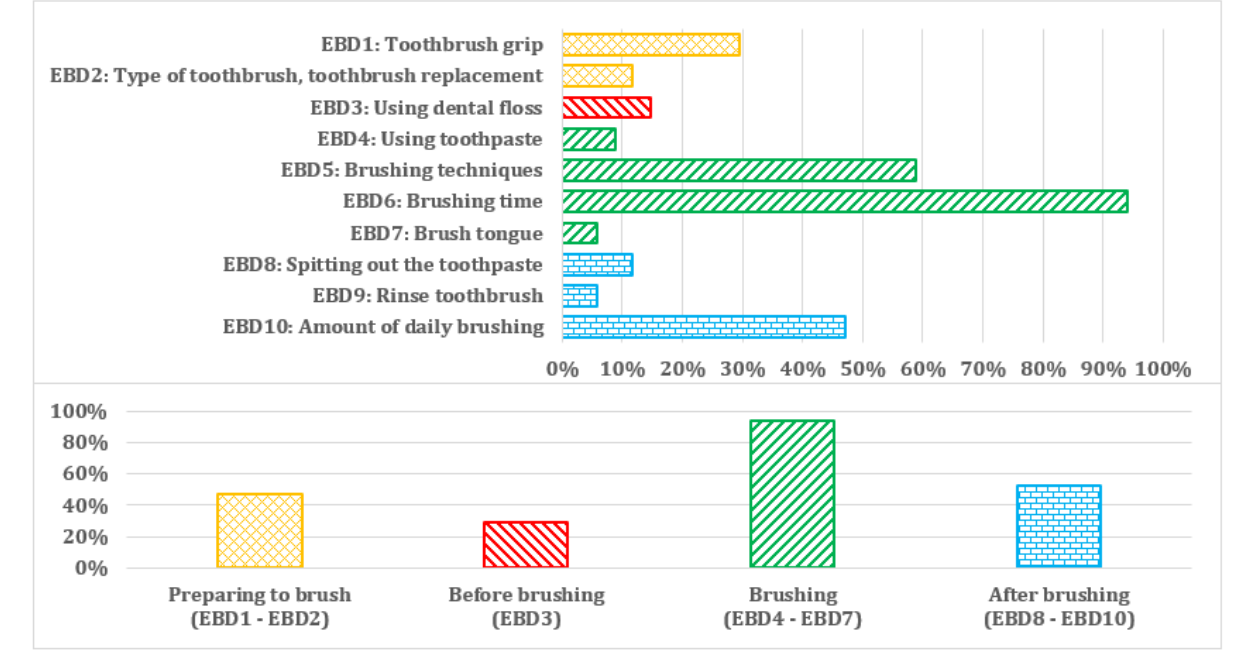
Figure 4. Group categories of evidence-based dentistry (EBD) oral hygiene-related content.